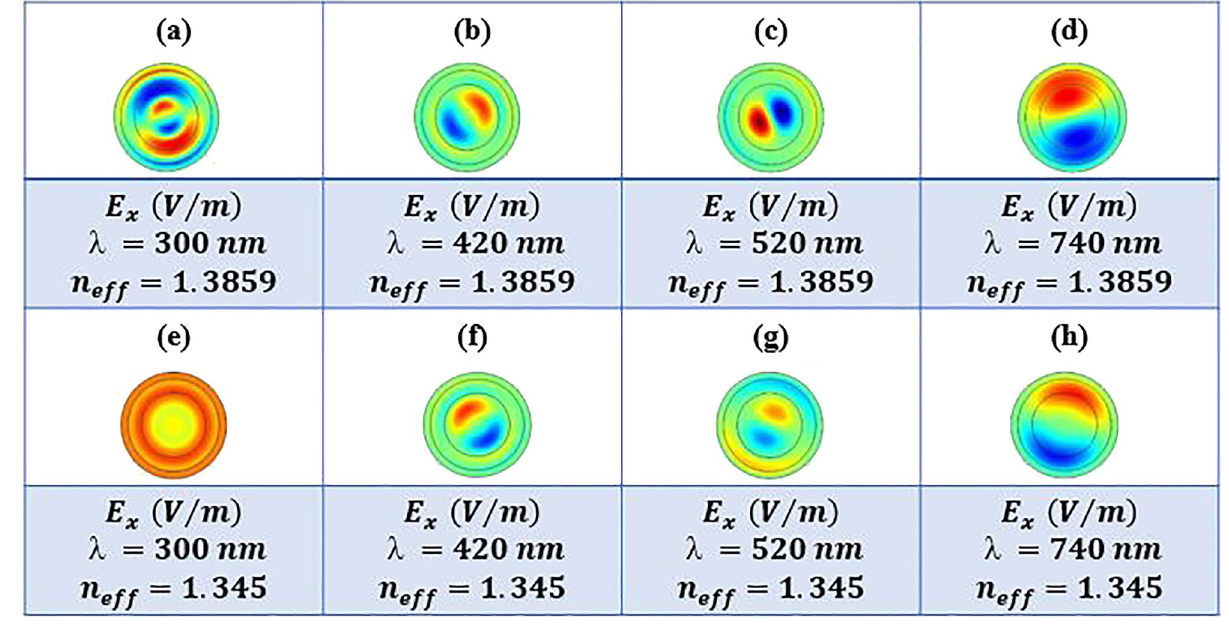
Figure 11. Electric field, E x , distributions in nerve fiber at four different wavelengths and two different effective RI values, n eff , while light is launched to the axon.